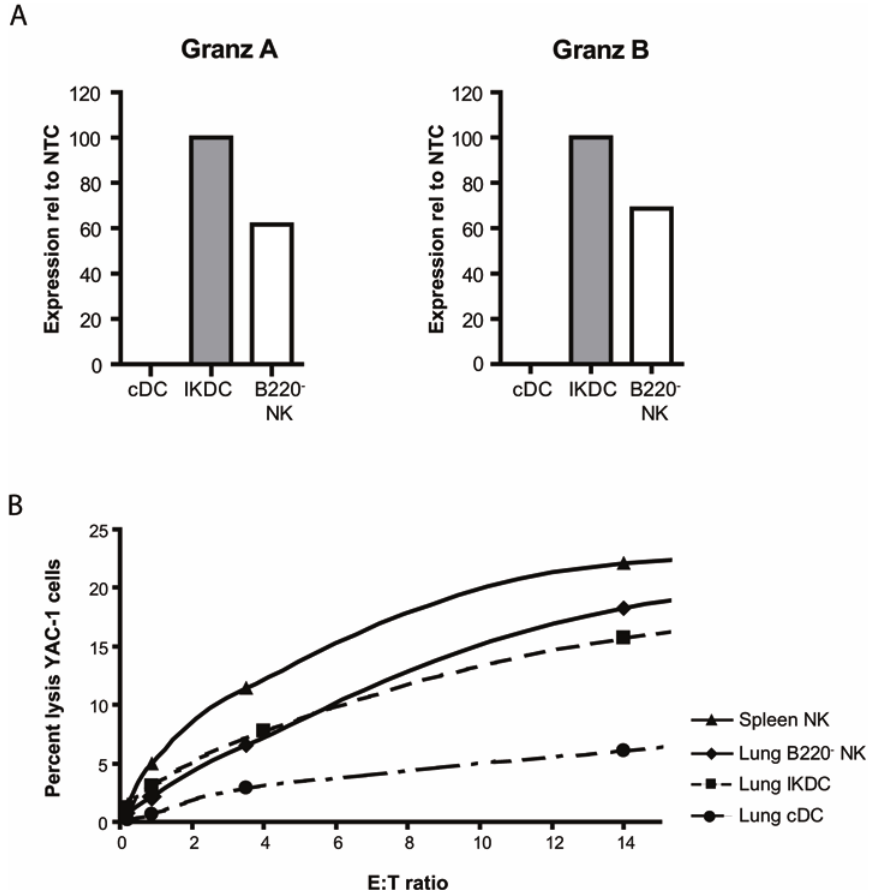
Figure 2. IKDCs and B220 2 NK cells induce cell lysis. (A) Expression of Granzyme A and B on sorted cell subsets at 4 dpi. Bars represent the values of expression relative to NTC. (B) Percentage YAC-1 cell target lysis after co-culture with different effector DC and NK cell subsets. IKDCs, B220 2 NK cells and DCs were sorted from lung tissue at 4 dpi following gating strategies depicted in Figure 1 and compared with enriched NK cells from spleen tissue. Cells were incubated with CFSE-labeled NK-sensitive YAC-1 target cells. Lysis at each effector:target (E:T) ratio was determined as described in materials and methods. Representative of 2 experiments.